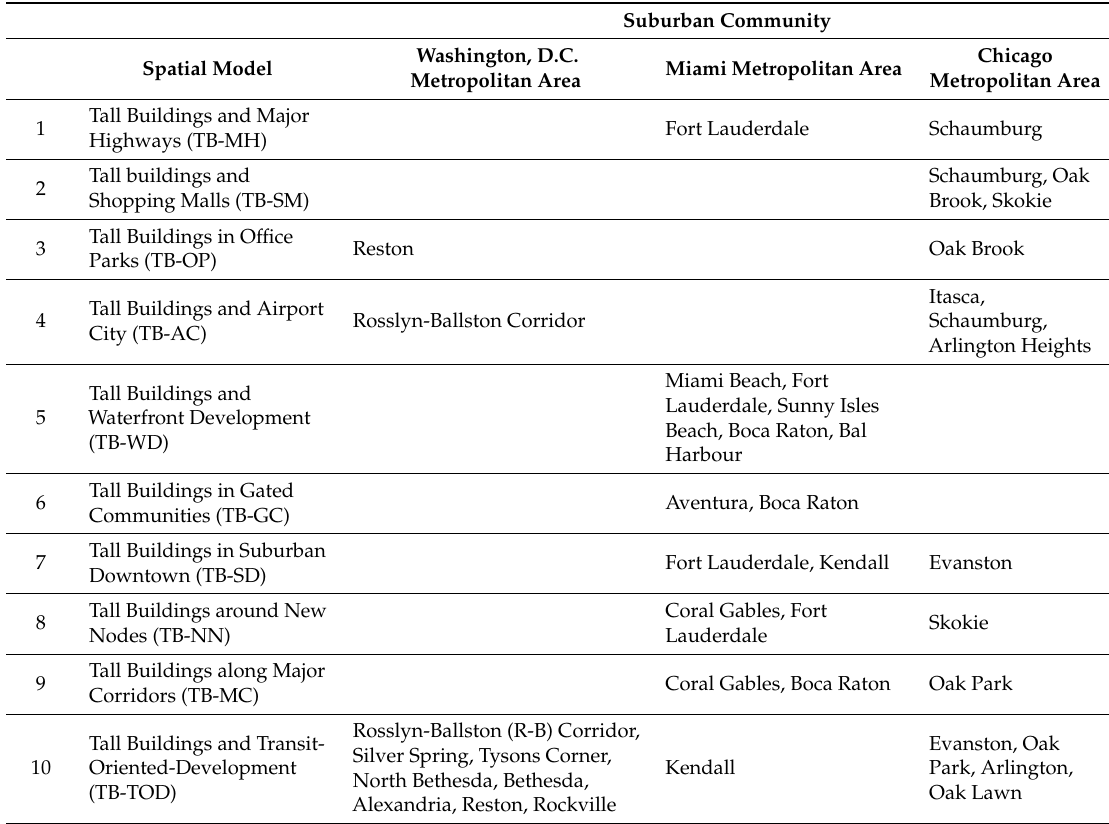
Table 7. Spatial Patterns of Tall Buildings in